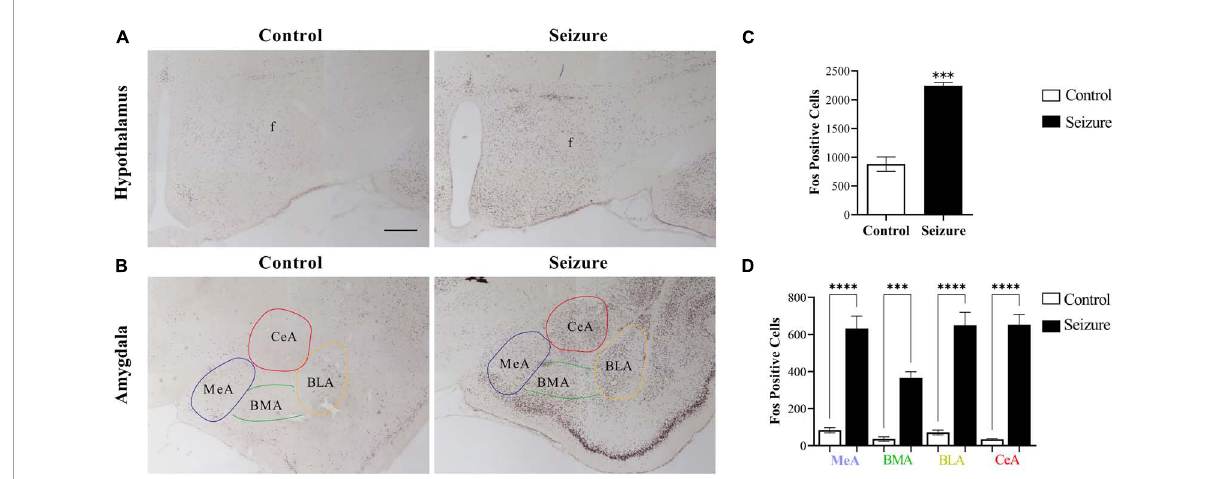
FIGURE2 Pilocarpine-induced status epilepticus led to neuronal activation in hypothalamus and amygdala. (A) Representative images of Fos immunohistochemical staining in the hypothalamus of a control and an epileptic rat; (B) representative images of Fos staining in the amygdala of a control and an epileptic rat. Bar: 500 µ m in (A) , which is also applicable in (B) . (C,D) Bar graphs show the number of Fos + cells in hypothalamus and amygdala in control (non-epileptic) and epileptic rats. ∗∗∗ P < 0.001, ∗∗∗∗ P < 0.0001, Student’s t -test (C) or two-way ANOVA (D) , n = 3 rats for each group. BLA, basolateral amygdaloid nucleus, anterior part; BMA, basomedial amygdaloid nucleus, anterior part; CeA, central amygdaloid nucleus, anterior part; f, fornix; MeA, medial amygdaloid nucleus, anterior